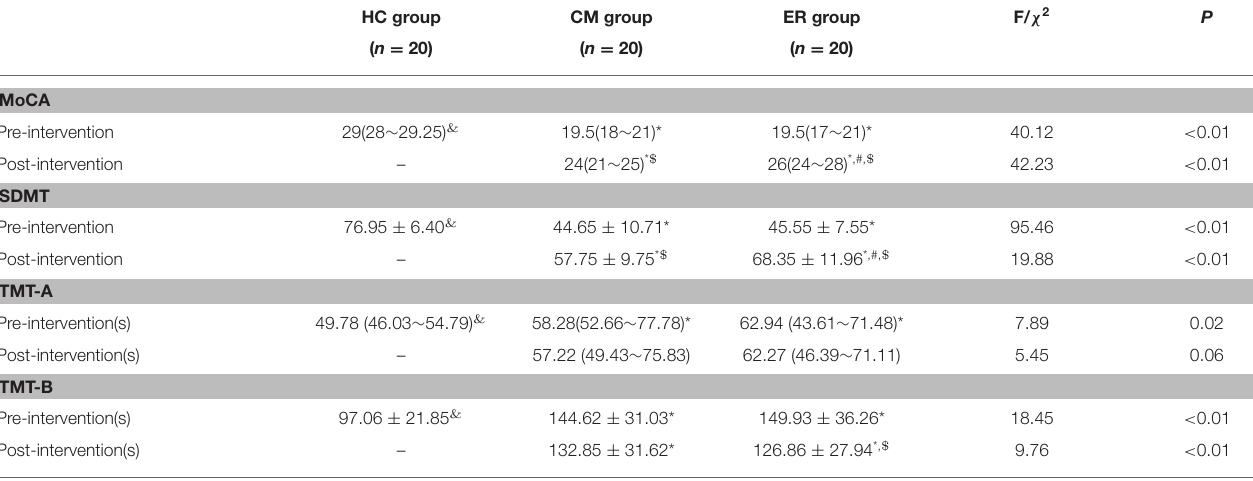
TABLE 2 | Indexes of cognitive function in each group during pre-intervention and post-intervention. HC group CM